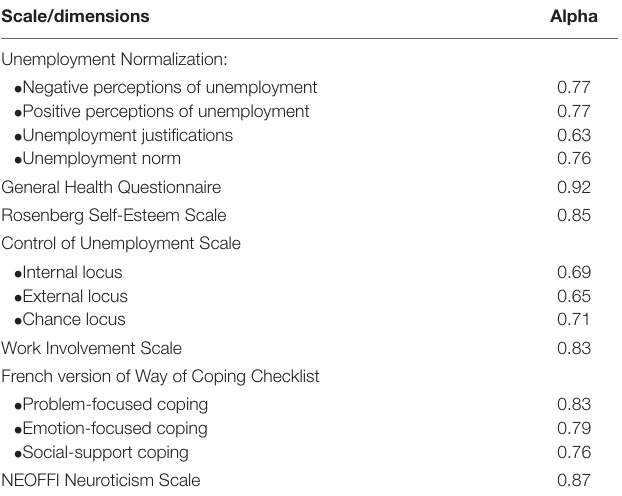
TABLE 1 | Cronbach’s alphas for each